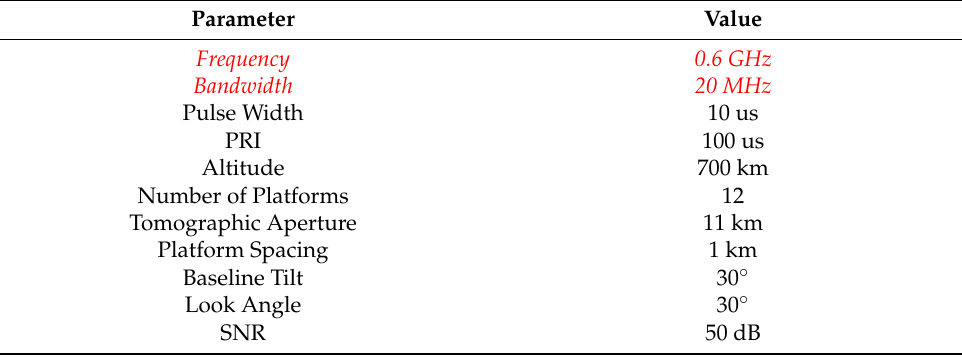
Table 6. Parameters used for Example